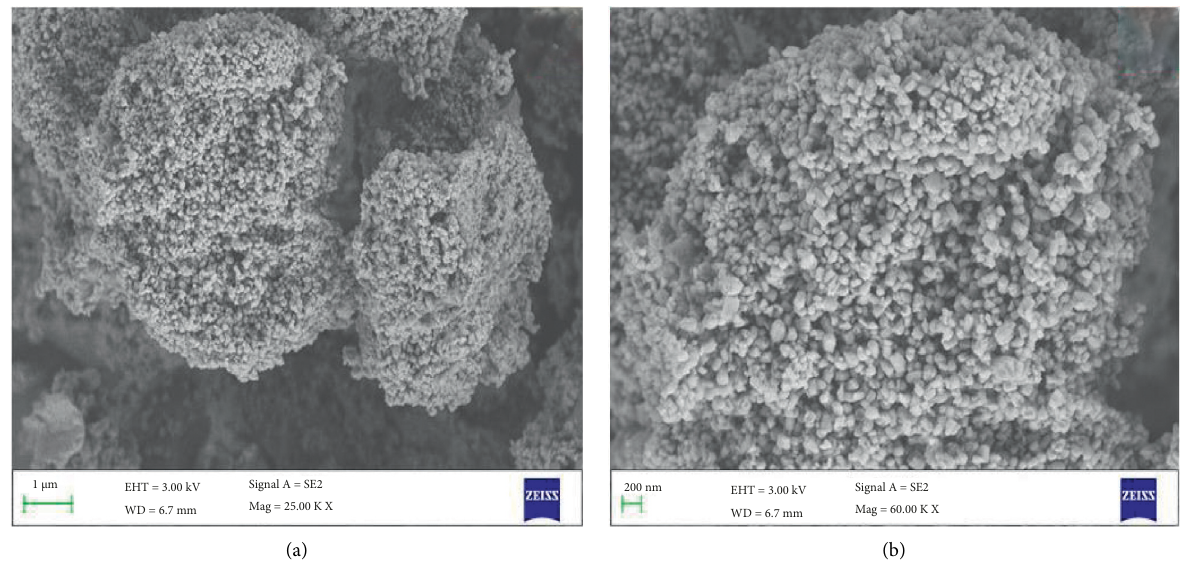
Figure 2: Lower (a) and higher (b) magnification FESEM image ZnO-TiO